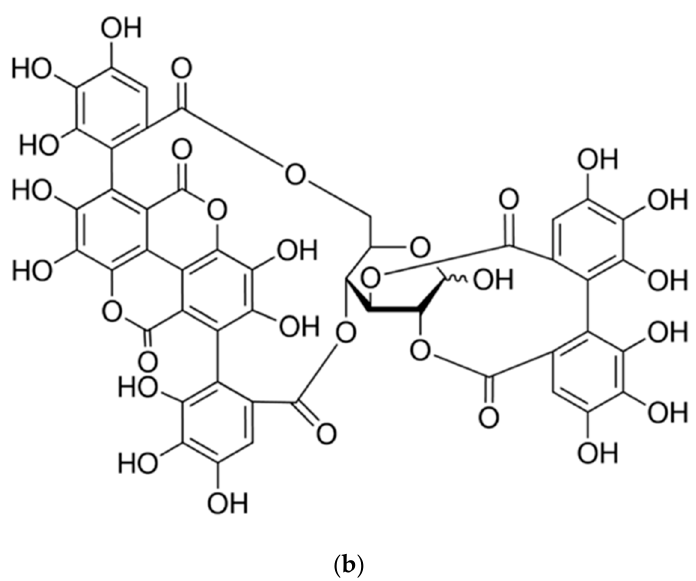
Figure 1. ( a ) Representative HPLC chromatogram of pomegranate rind extract (PRE). Note: the α and β anomers of punicalagin are in a characteristic 1:2 ratio. ( b ) Chemical structure of punicalagin.